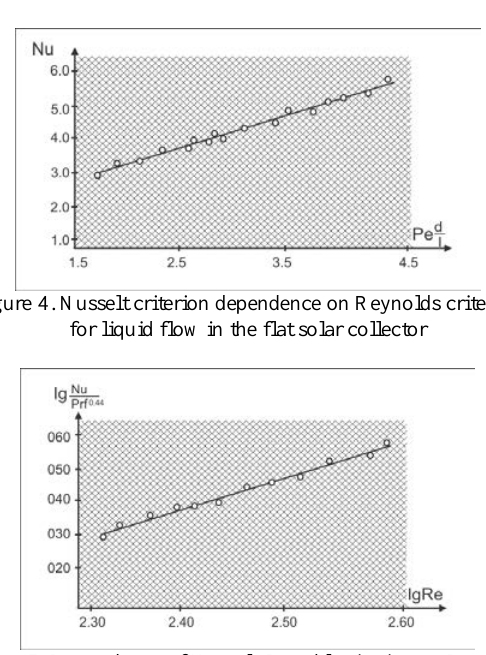
Figure 5. Dependence of Nusselt-Prandtl criterion on Reynolds